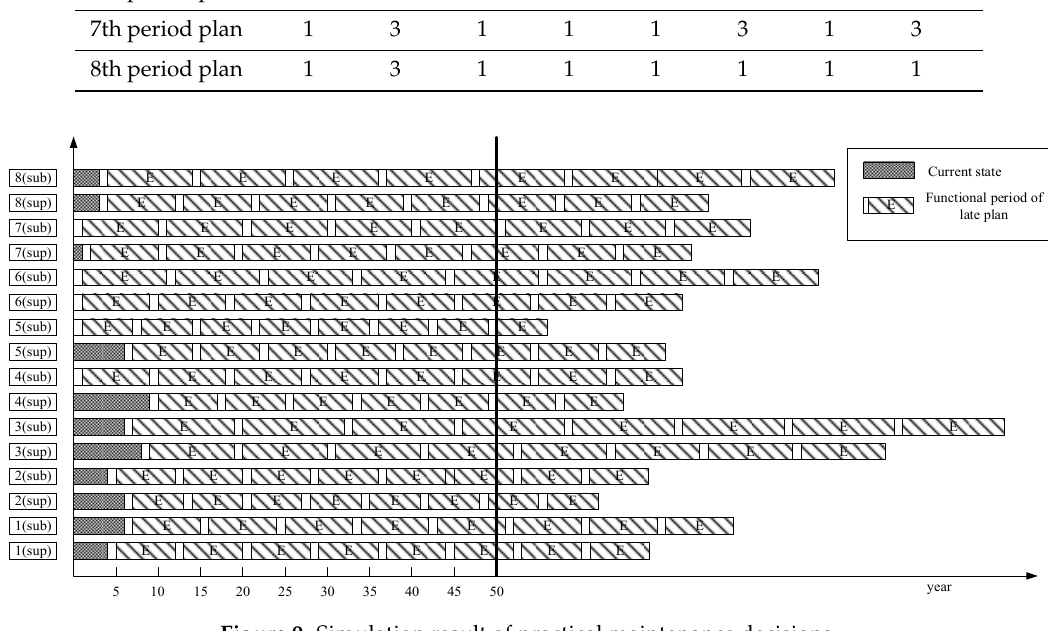
Table 10. Calculation results of effect period.